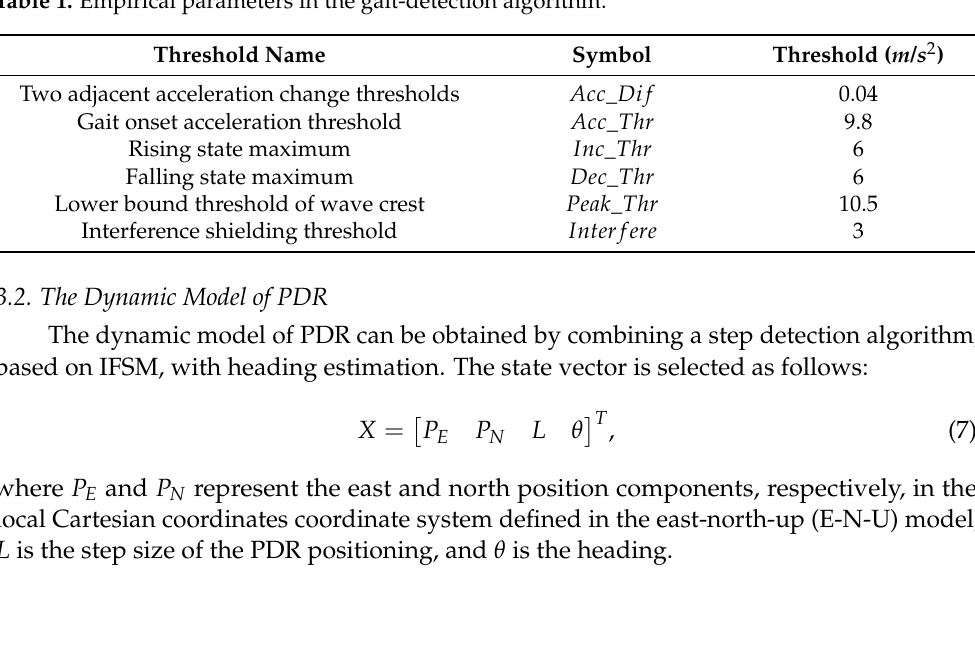
Table 1. Empirical parameters in the gait-detection